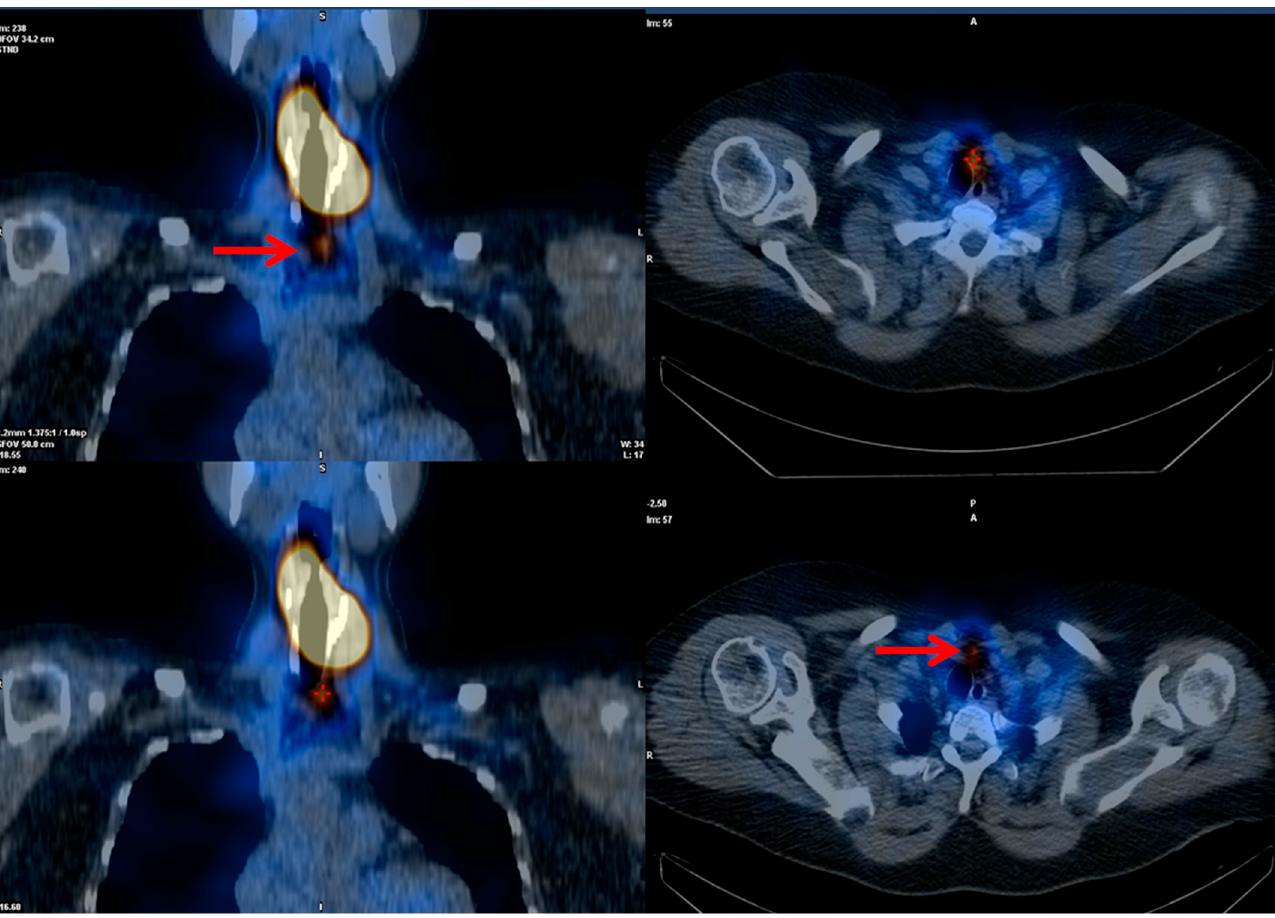
Figure 2. Post ‐ treatment high ‐ activity 131 I whole ‐ body scintigraphy. Large thyroid remnant with a Figure 2. Post-treatment high-activity 131 I whole-body scintigraphy. Large thyroid remnant with a small single iodine ‐ avid lymph node metastasis (red arrows) at central neck compartment. small single iodine-avid lymph node metastasis (red arrows) at central neck